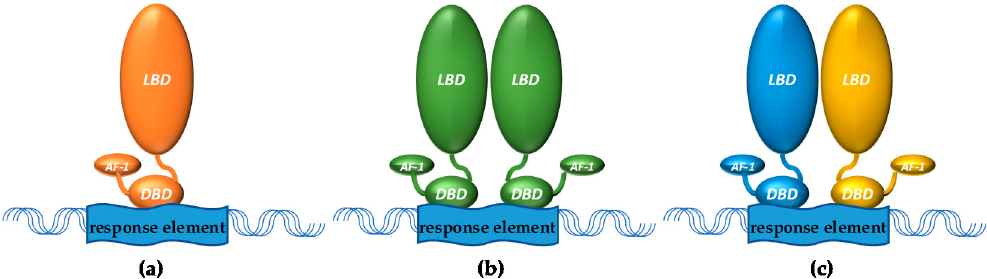
Figure 1. NRs can bind as ( a ) monomers (e.g., certain orphan receptors), ( b ) homodimers (e.g., steroid hormone receptors), or ( c ) heterodimers (often with RXR) to DNA response elements. LBD = ligand binding domain, DBD = DNA binding domain, AF-1 = activation function 1.